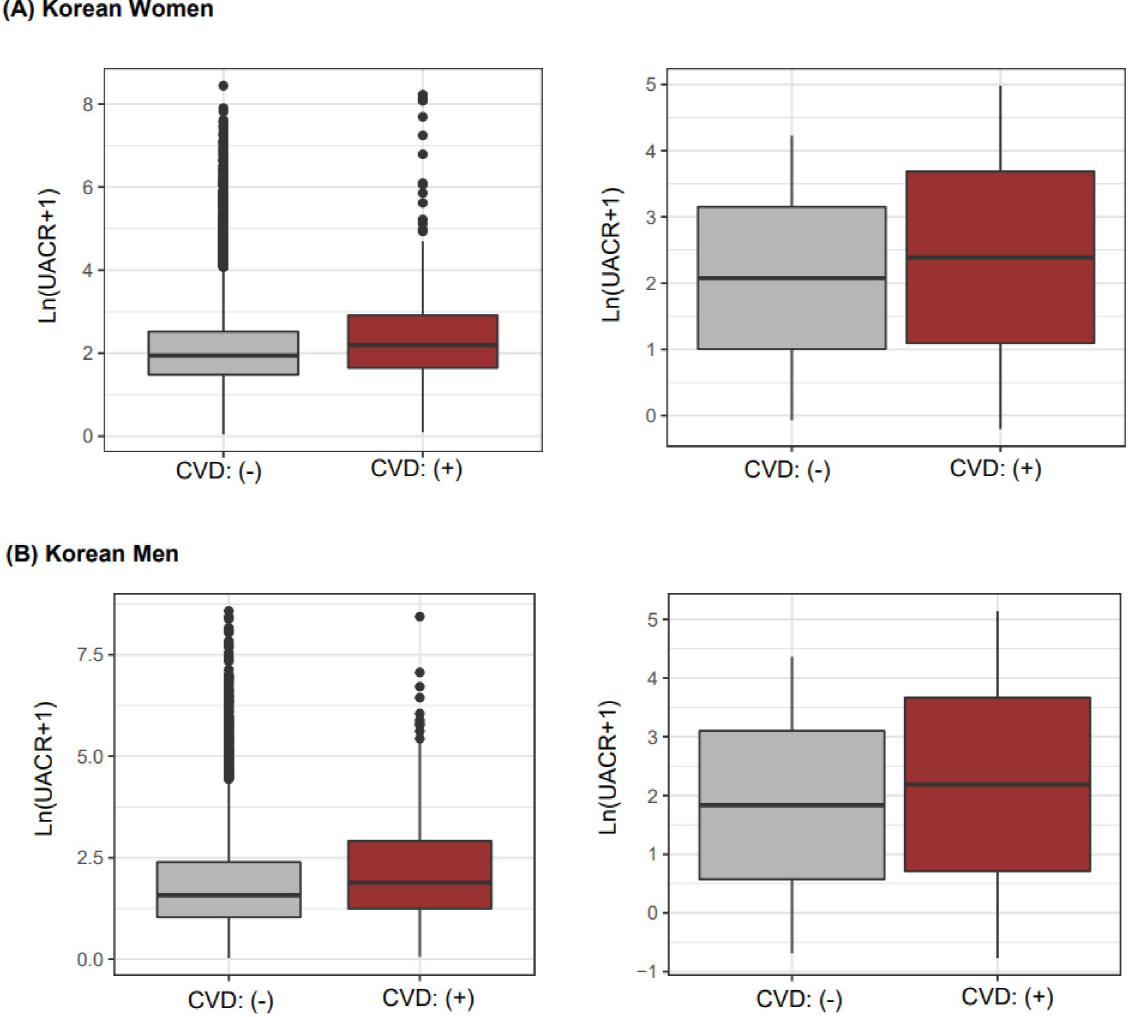
Fig 1. UACRs according to CVD status in Korean women (A) and men (B). Left side boxplots (grey and brown colored boxes) indicate median-based summary statistics; specifically, the middle, upper, and lower lines describe median, 75, and 25 percentile values, respectively. Right side boxplots indicate mean-based summary statistics, in which the middle, upper, and lower lines illustrate mean, one standard deviation values, respectively.